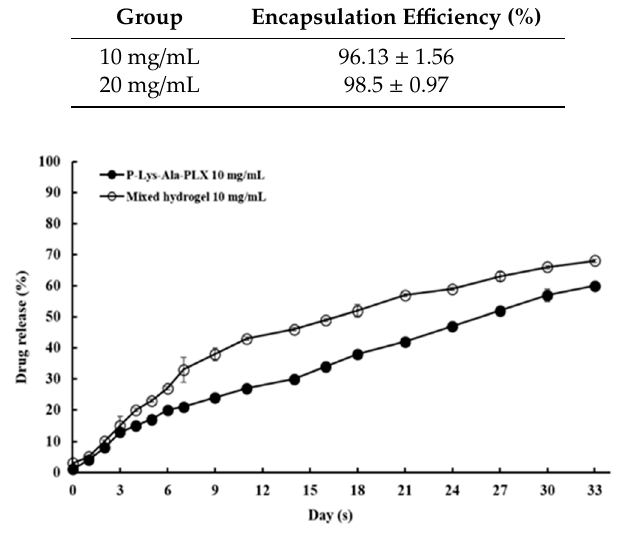
Figure 9. In vitro tacrolimus release as a fraction of total encapsulated drug. Table 3. The encapsulation efficiency of 5:1 mixed hydrogel for tacrolimus.